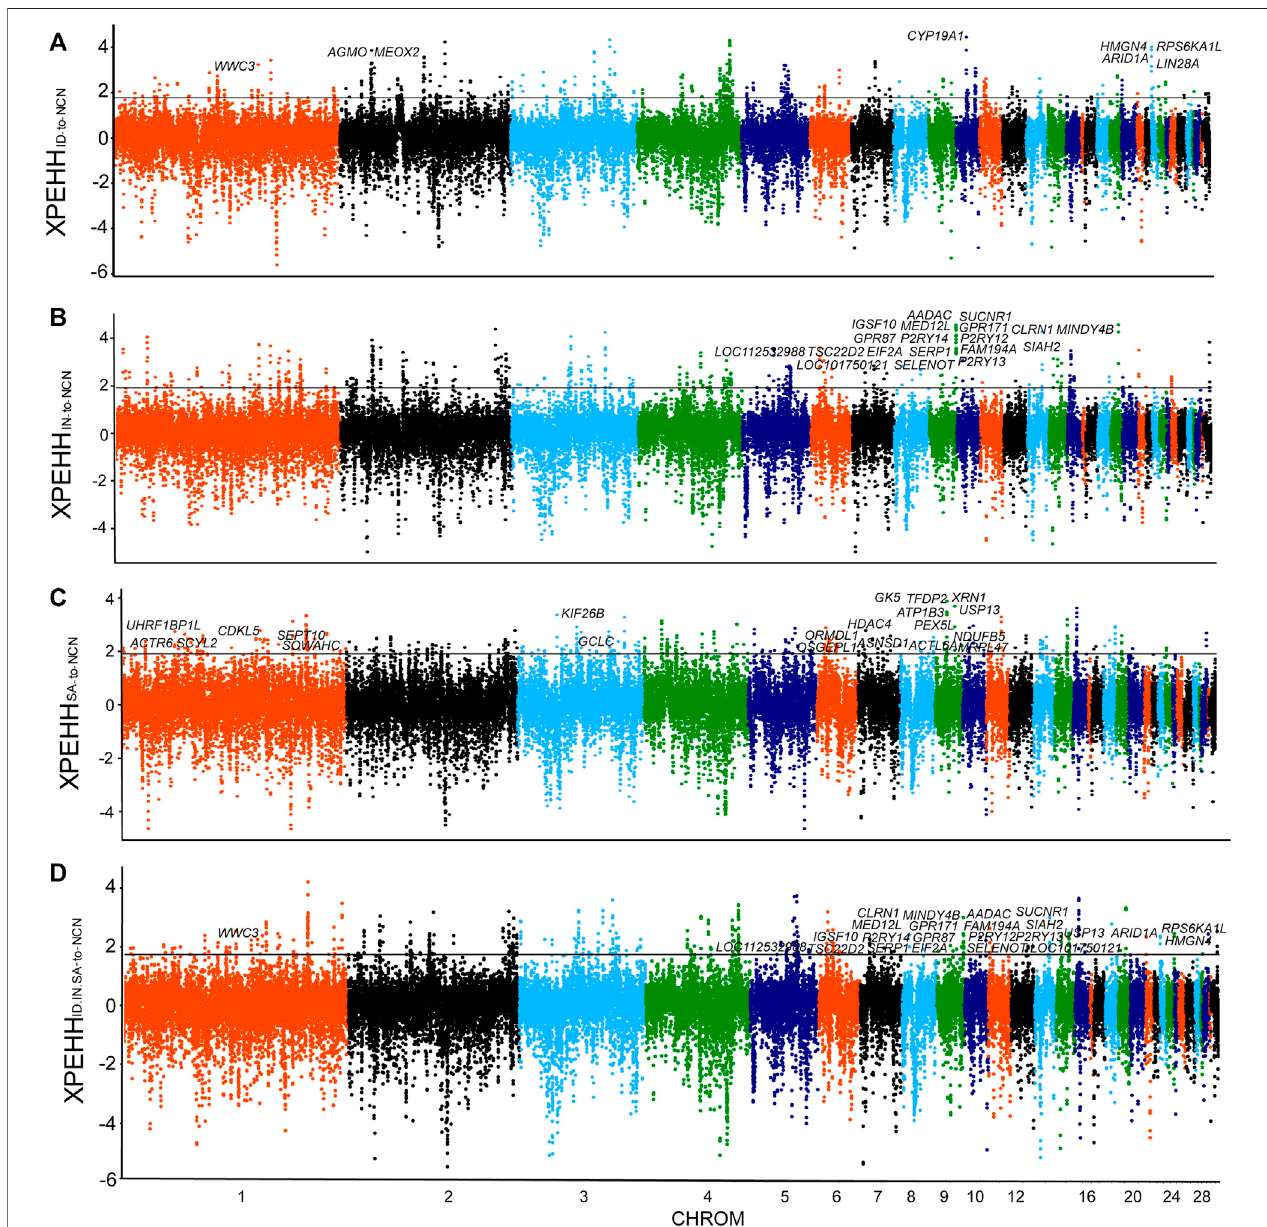
FIGURE 2 | Selection Sweeps analysis. (A) XP-EHH analysis (ID chickens to NCN chickens). (B) XP-EHH analysis (IN chickens to NCN chickens). (C) XP-EHH analysis (SA chickens to NCN chickens). (D) XP-EHH analysis (ID.IN.SA chickens to NCN chickens). Sliding window analyses with 40-kb window and 20-kb increment, using 99th percentile